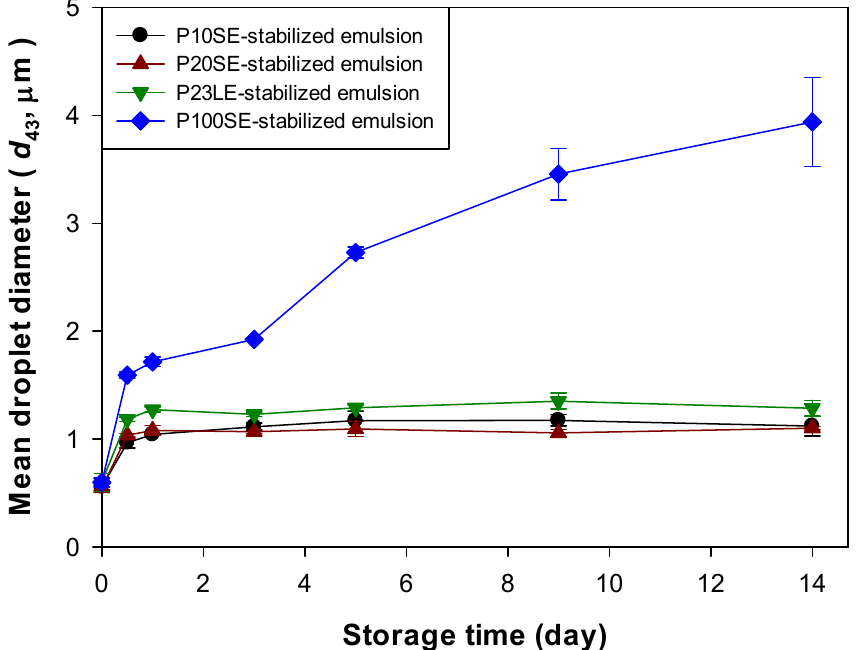
Figure 2. Changes in the mean droplet diameter (volume-length mean diameter, d 43 ) of orange oil-in-water emulsions stabilized with ethylene glycol alkyl ether